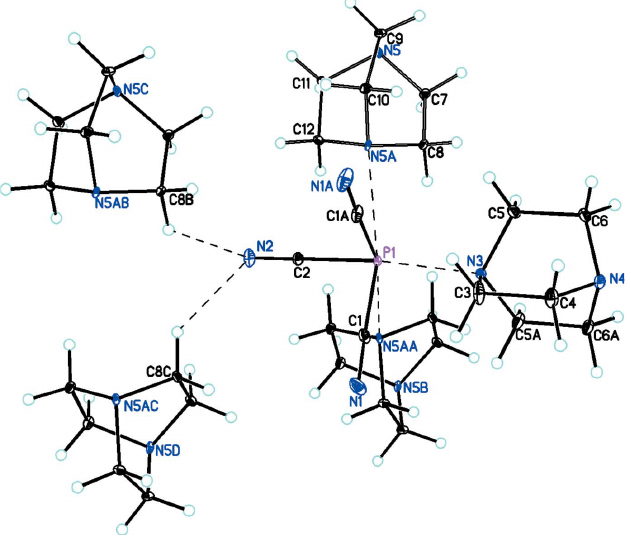
Figure 5 Diagram for 2 showing the bifurcated interaction of N2 with two C 6 H 12 N 2 units (shown as dashed bonds). Atomic displacement parameters are at the 30% probability level. The symmetry codes to generate the N2 (cid:3)(cid:3)(cid:3) H interactions are (cid:4) x , 1 (cid:4) y , 2 (cid:4) z , and (cid:4) x , y (cid:4) 1